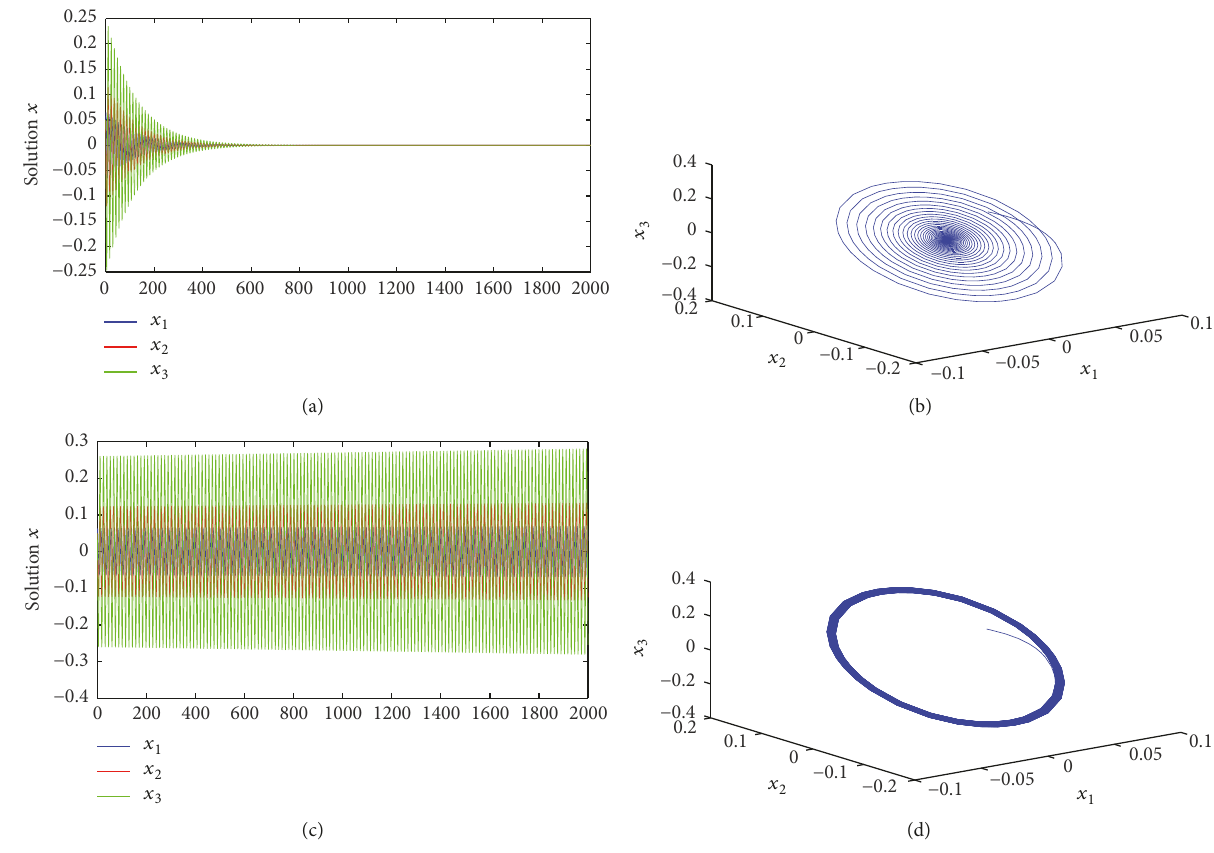
Figure 4: Time waveforms and phase portrait of the PI hydroturbine governing system. (a) Time waveforms with 0 < 𝜏 1 < 𝜏 10 . (b) The phase portrait with 𝜏 1 = 0.75 s < 𝜏 10 . (c) Time waveforms for 𝜏 1 = 0.92 s > 𝜏 10 . (d) The phase portrait with 𝜏 1 = 0.84 s > 𝜏 10